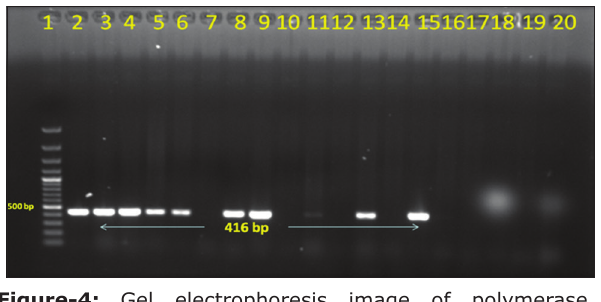
Figure-4: Gel electrophoresis image of polymerase chain reaction amplified products of tetB gene of Gram- negative isolates. Lane 1 - 1500 bp DNA ladder; Lane 2-14, 16-19 - Isolated Escherichia coli samples; Lane 15 - Positive control for tetB gene; Lane 20 - Negative